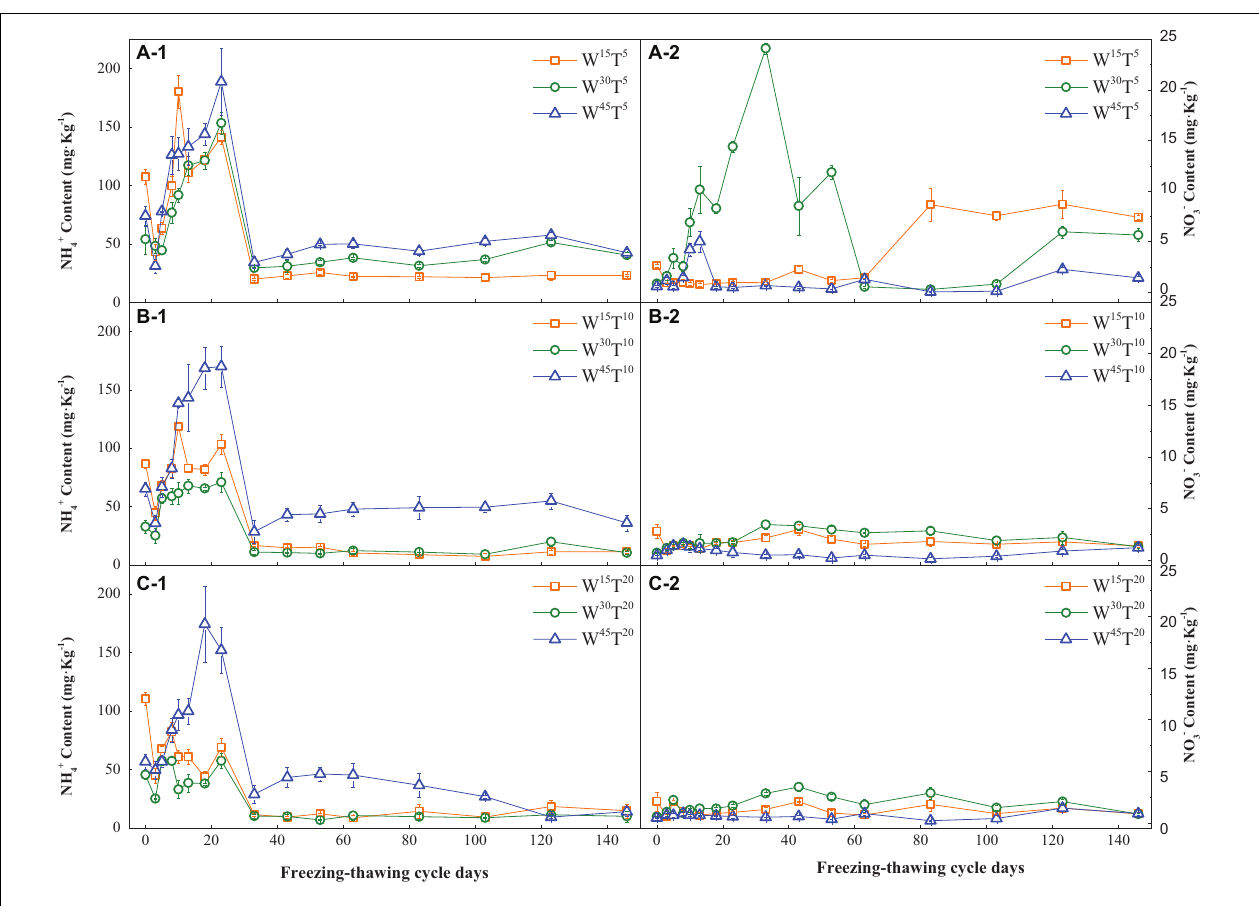
FIGURE 3 | Dynamics of the (A-1 , B-1 , C-1) ammonium and (A-2 , B-2 , C-2) nitrate contents in different treatments.